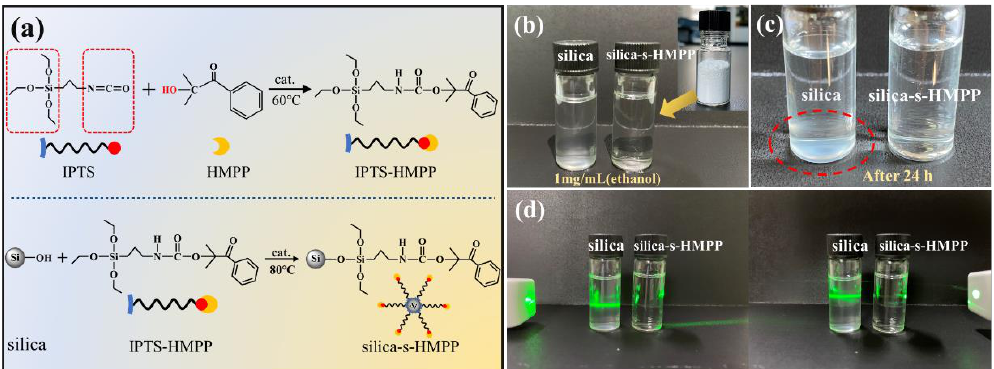
Figure 1. ( a ) Illustration of the hybrid photoinitiator silica-s-HMPP preparation ( b ) photos of original state of the silica and silica-s-HMPP dispersing in ethanol (1 mg/mL) and ( c ) standing for 24 h, ( d ) the photos of silica and silica-s-HMPP ethanol solution under a laser irradiation, respectively.